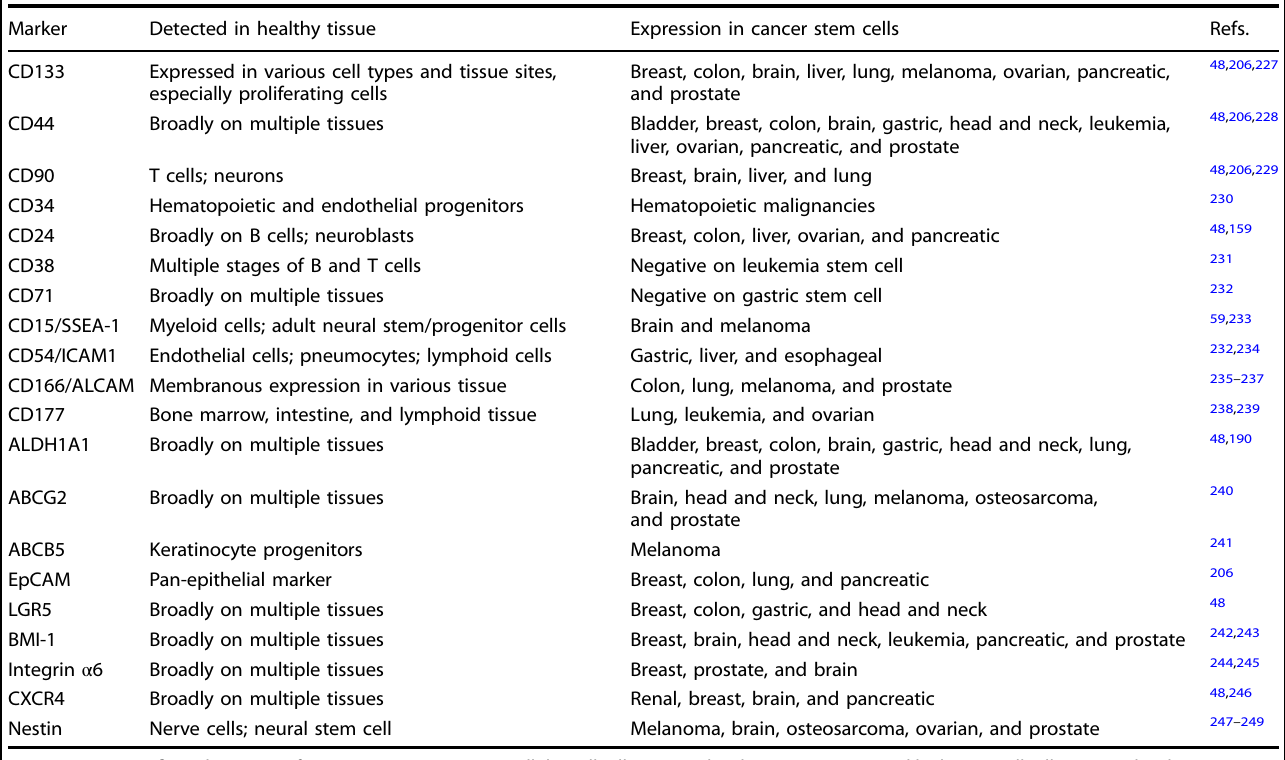
Table 1. Surface markers used for the identi fi cation of CSCs